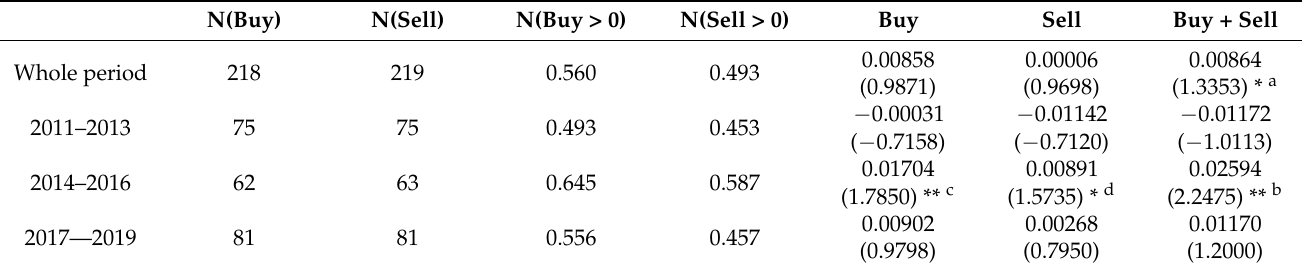
Table 10. t -test Output for the MACD (4,22,3) Model with the ‘1st-pkbm’ Search Strategy vs. the MACD (12,26,9)